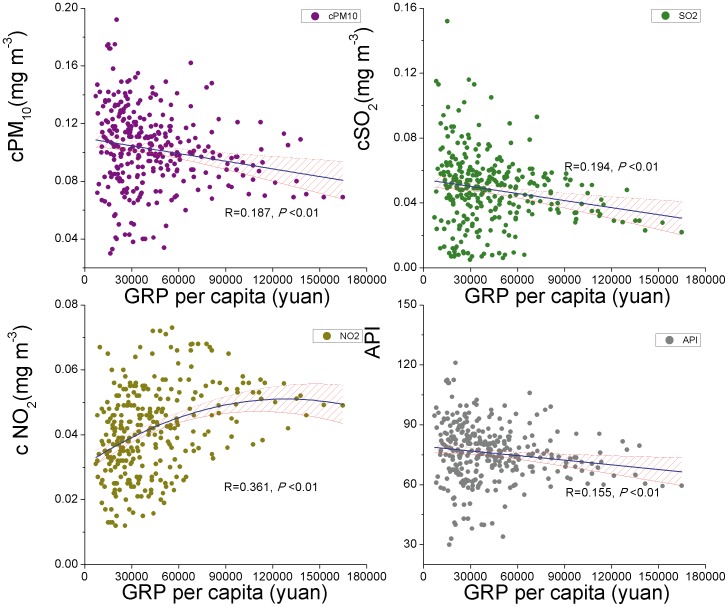
Regression curves between GRP per capita and air pollutant index (PM10, SO2, NO2, API) in all the provincial capital cities during 2003–2012.The blue line is the regression line and the pink area the 95% confidence limits.